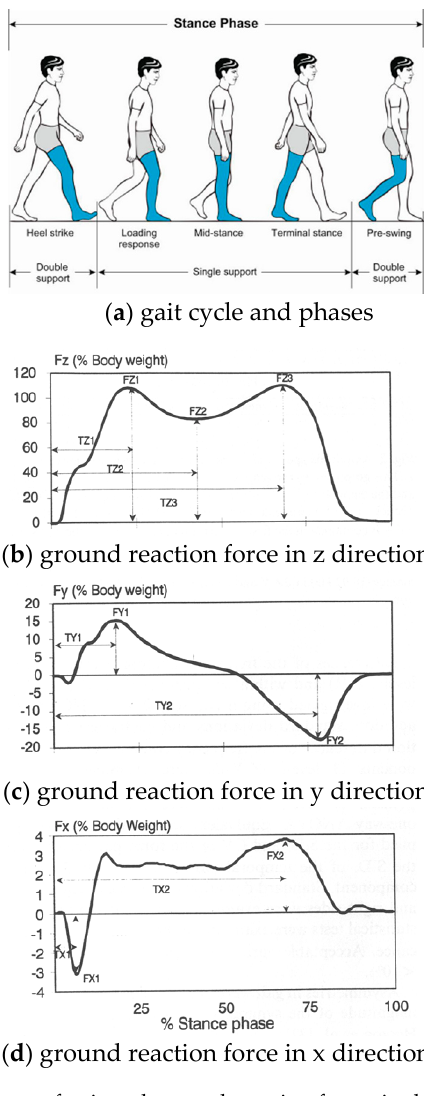
Figure 16. Stance phase of gait and ground reaction forces in the time domain [137].